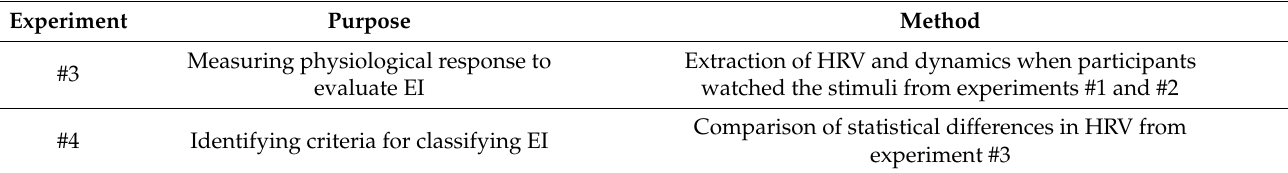
Table 3. Main experiments to measure HRV and classify